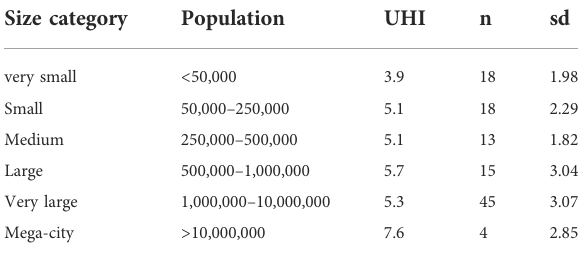
TABLE 1 UHI estimates by city population size. This table presents the results of our literature review on ambient temperature UHI observations for over 110 cities across the world. The values are the means (degrees Celsius) and standard deviations of the samples aggregated by urban population size. We based our analysis on Manoli, et al.